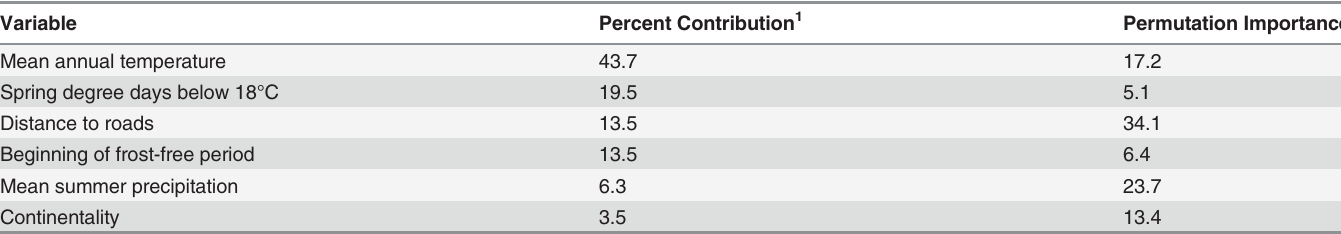
Table 1. Variables and their relative contribution in the fi nal MaxEnt